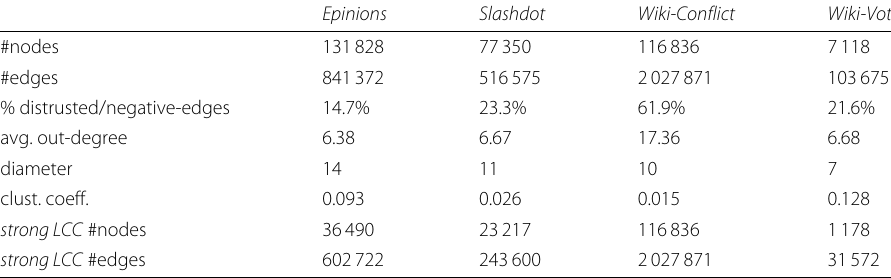
Table 2 Summary of evaluation network